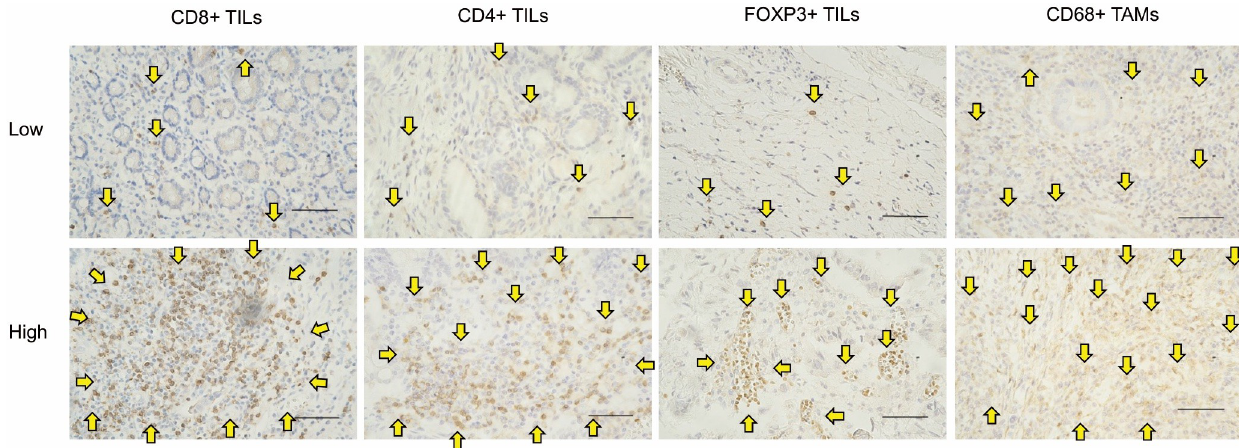
Fig 1. Immunohistochemical staining. Microscopic images showing high- and low-infiltration groups with CD8+, CD4+, FOXP3+, and CD68+ cells. Magnification is 400x, and the scale bar is 25 μ m. Immune cells around the tumor are stained brown (arrows). Each patient is classified into the high- or low-infiltration group based on the cutoff